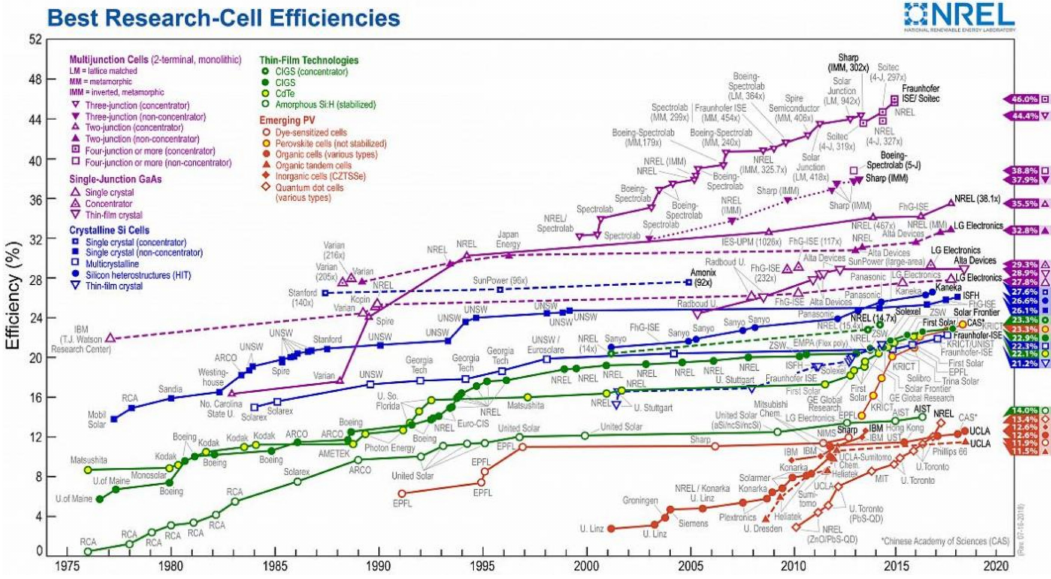
Figure 1. Photoelectric conversion e ffi ciencies for various photovoltaic technologies since 1976 by National Renewable Energy Laboratory (NREL)